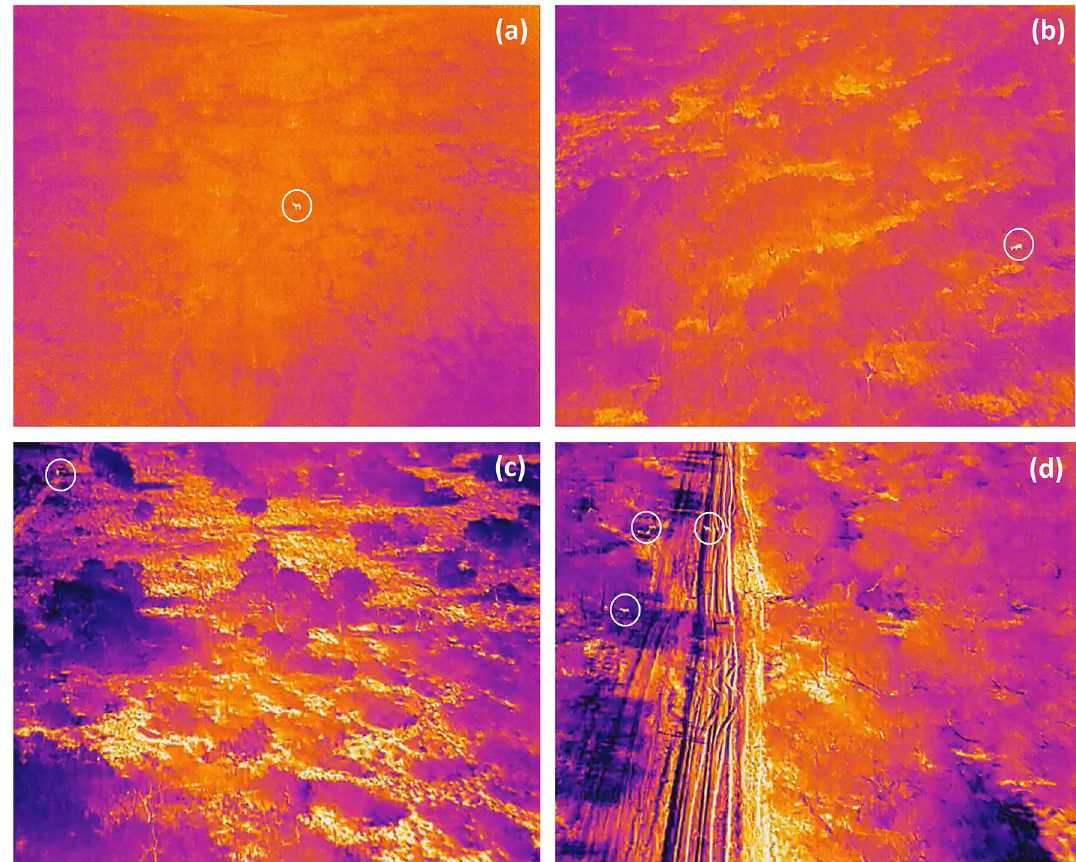
Figure 2. Thermal images indicating white-tailed deer ( Odocoileus virginianus ) detections from video footage during drone surveys in South Texas, USA in 2020. The top images highlight detections below ( a ) 20 °C and ( b ) 27 °C on a sunny and cloudy days respectively. The bottom images highlight detections above ( c ) 20 °C and ( d ) 27 °C on a sunny and cloudy days respectively. White circles indicate white-tailed deer detections. Orange and yellow areas were hotter and deer within these areas would not be